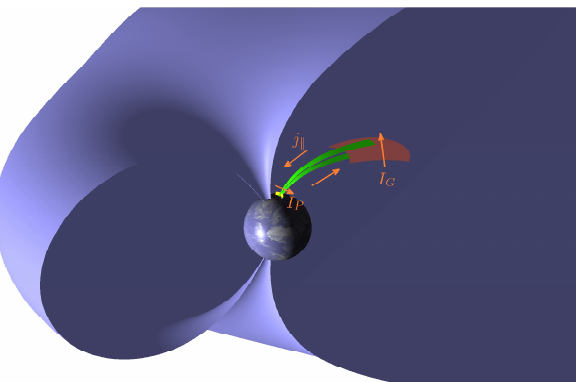
Fig. 1. A magnetospheric interface (brown) connects via field- aligned currents j k to the ionosphere, where the current system is closed by an ionospheric current (Pedersen current I P ). The driver is a generator current I G across the